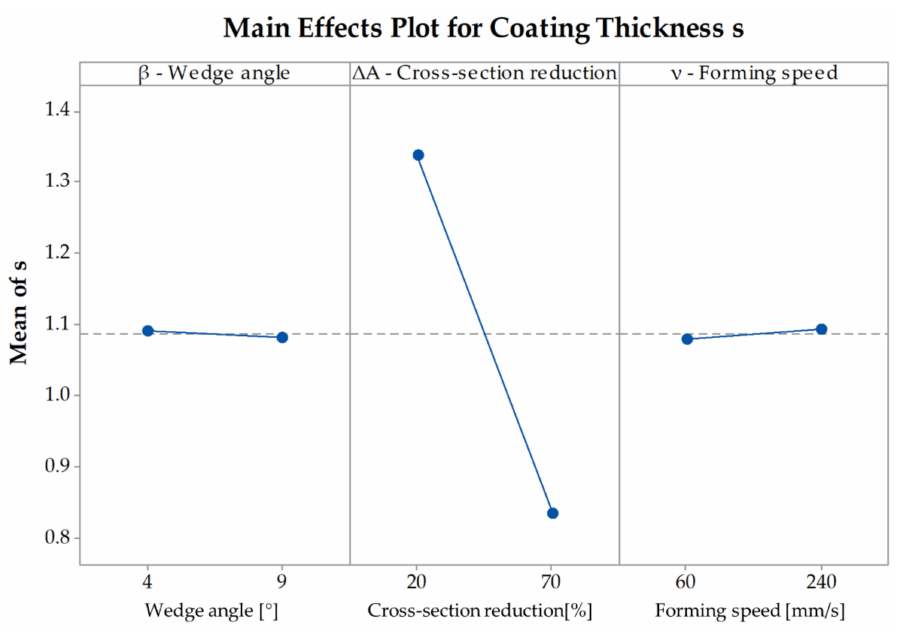
Figure 14. Main E ff ects Plot for the coating thickness s in the experimental trials. For every analyzed parameter configuration, the coating thickness decreased after CWR. The most obvious change took place at the cross-section reduction of ∆ A = 70%, whereas the decrease at ∆ A = 20% reduction is less